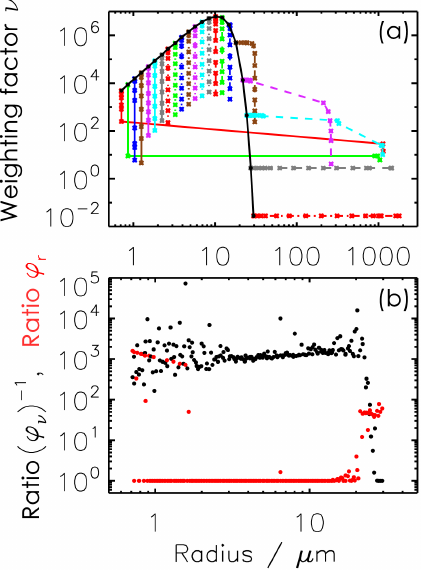
Figure 4. The same as Fig. 3 but for